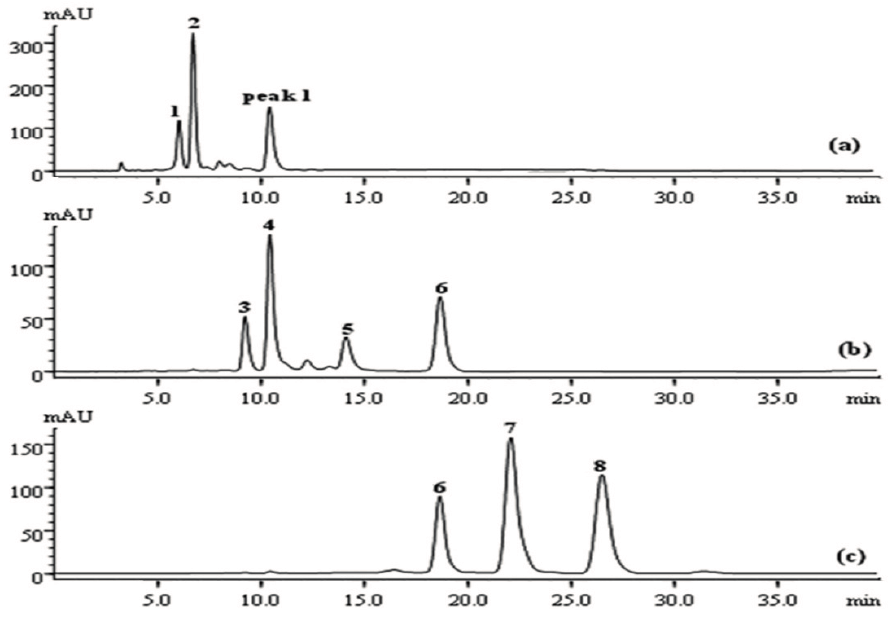
Figure 5. HPLC analyses of the residual elutions: Fraction 1 ( a ); Fraction 2b ( b ); remainder of Fraction 4 ( c